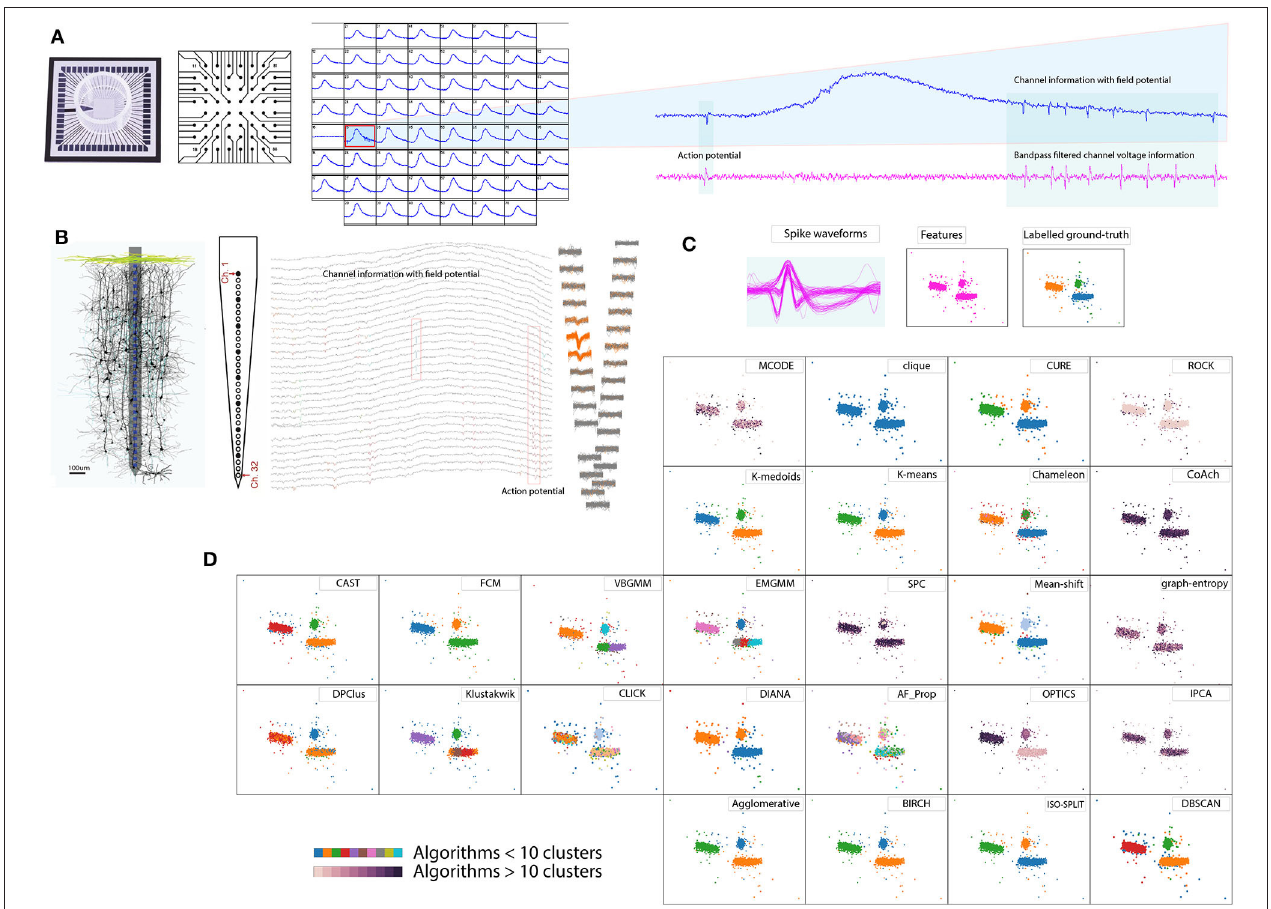
FIGURE 1 | Spike sorting overview. (A) In vitro method 60 electrode MEA, schematic cross-section and example recordings (Gaburro et al., 2018a,b). (B) In vivo method 32 electrode array, schematic cross-section and example recordings (Schjetnan and Luczak, 2011; Rossant et al., 2016). (C) Pool of spikes extracted from the recordings, features extracted, and labeled ground-truth (Quiroga et al., 2004). (D) Example of cluster algorithms results addressed in the report for the data set in (C) , demonstrating diverse choices available for spike